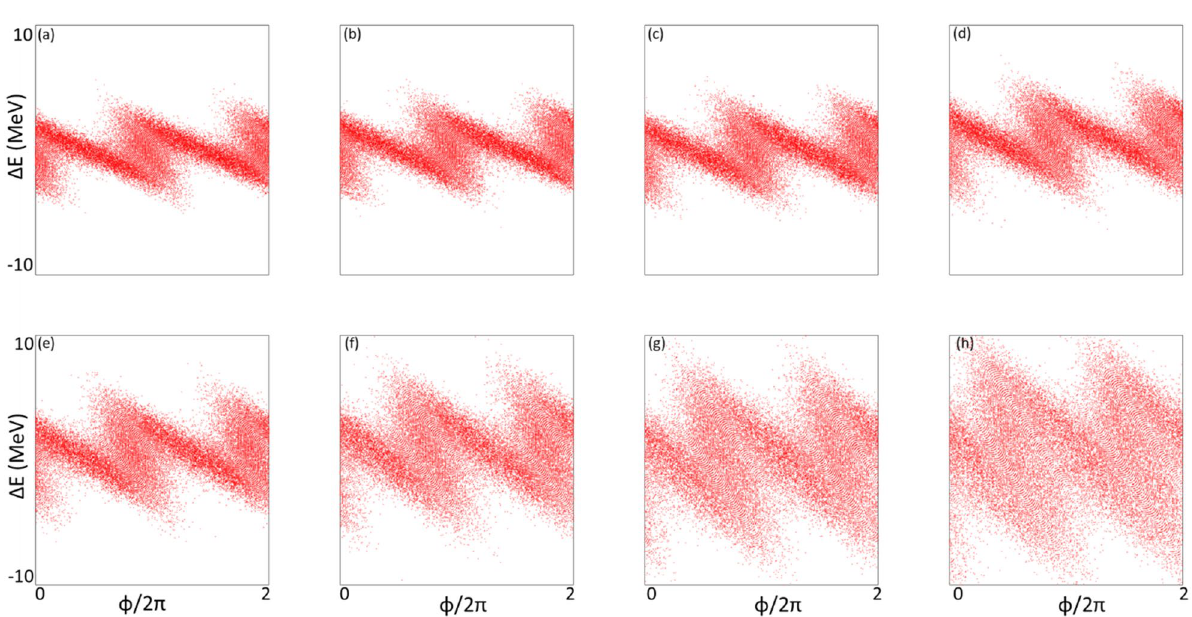
Figure 8. Longitudinal phase spaces corresponding to the energy modulations of stage 1 with the values of 0.667 ( a ), 1.000 ( b ), 1.333 ( c ), 1.667 ( d ), 2.000 ( e ), 3.000 ( f ), 4.000 ( g ), and 5.000 ( h ) are